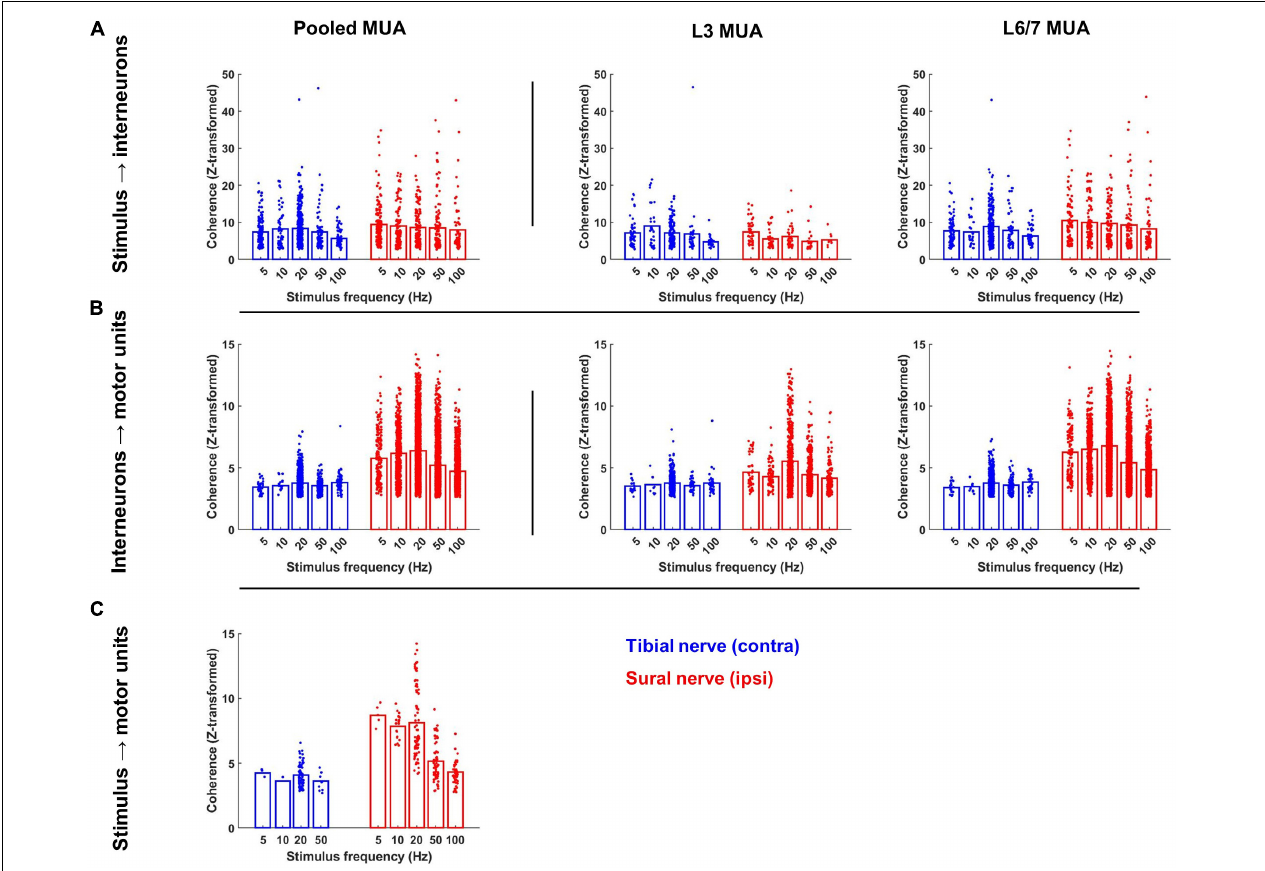
FIGURE 7 | Magnitude of significant coherence during contralateral tibial and ipsilateral sural nerve stimulation across frequencies. (A) Peak of coherence between the stimulus pulse train and each interneuron; (B) each interneuron and motor unit; and (C) the stimulus pulse train and each motor unit at the stimulation frequency. Bars represent the mean coherence value after z-transformation; individual data points have been jittered with uniformly distributed noise to minimize overlap.